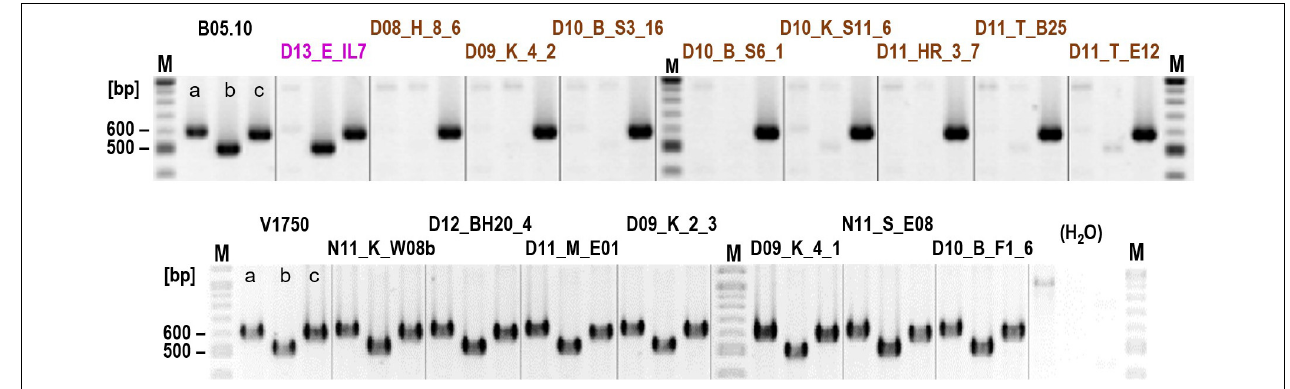
FIGURE 2 | Detection of genes involved in the synthesis of botrydial and botcinic acid in B. cinerea strains. Agarose gel-separated PCR products for boa17 (lanes a), boa6 (lanes b), and bot2 (lanes c) are shown. B. cinerea B strains are marked in brown and the Iris isolate in